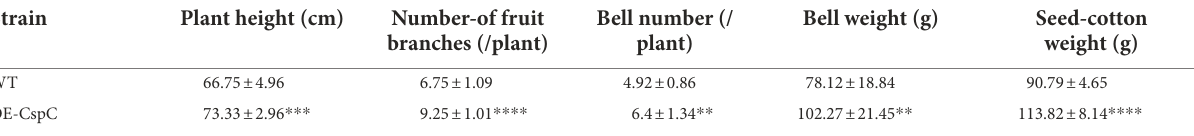
TABLE 2 Agronomic traits and yield of cotton in the field. Strain Plant height